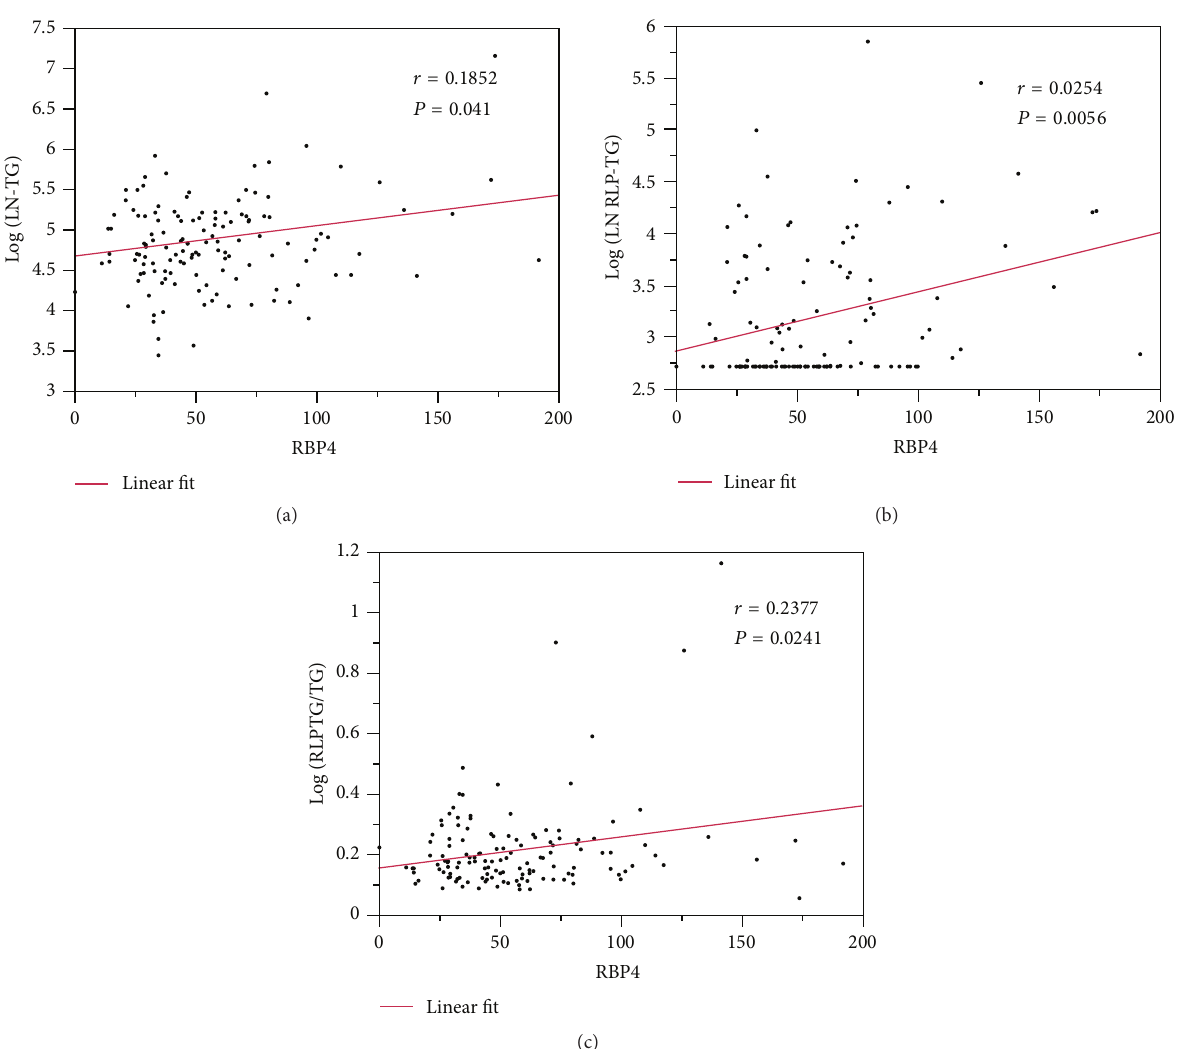
Figure 1: Relationship between serum RBP4 levels and logarithm transformed triglyceride (TG) levels (a), logarithm transformed RLP-TG levels (b), and RLP-TG/TG ratio